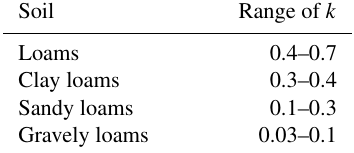
Table 3. Soil erodibility factor k .